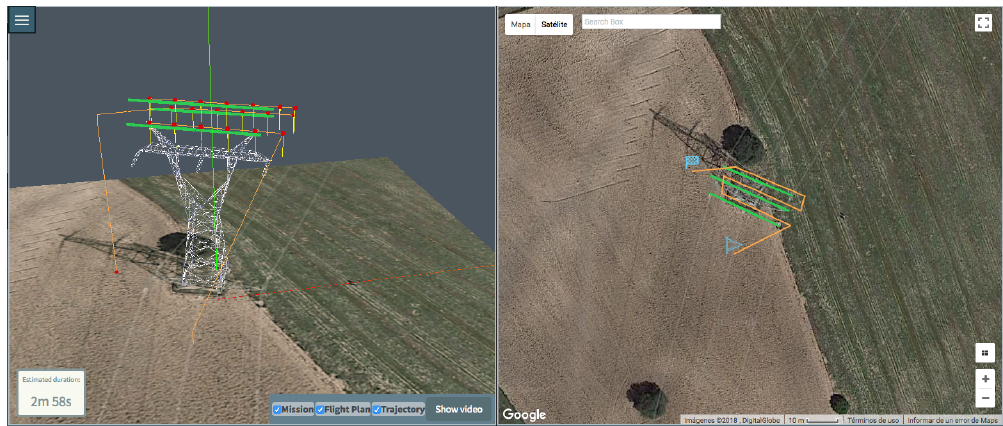
Figure 9. Generated Flight Plan and Trajectory for high voltage tower: ( left ) lateral, ( right ) zenit.